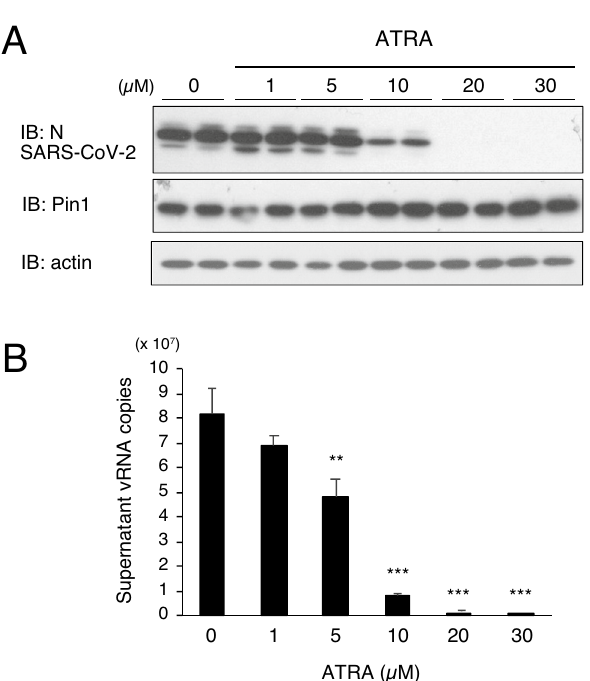
Figure 5. ATRA with Pin1 inhibitory activity also inhibits SARS-CoV-2 proliferation. VeroE6/TMPRSS2 cells were pretreated with indicated concentrations of ATRA for 2 h and subsequently infected with SARS-CoV-2 (MOI of 0.01) followed by incubation for 24 h. ( A ) Western blotting of cell lysates with SARS-CoV-2N, Pin1, and actin antibodies (Duplicate in the figure). Full-length blots are presented in Supplementary Fig. 4. ( B ) Copy number per PCR reaction (8 µl) of vRNA in the culture supernatant 24 h after infection (n = 3). Error bars represent standard deviation. ** P < 0.01, *** P < 0.001, Mann–Whitney U test, compared with 0 µM